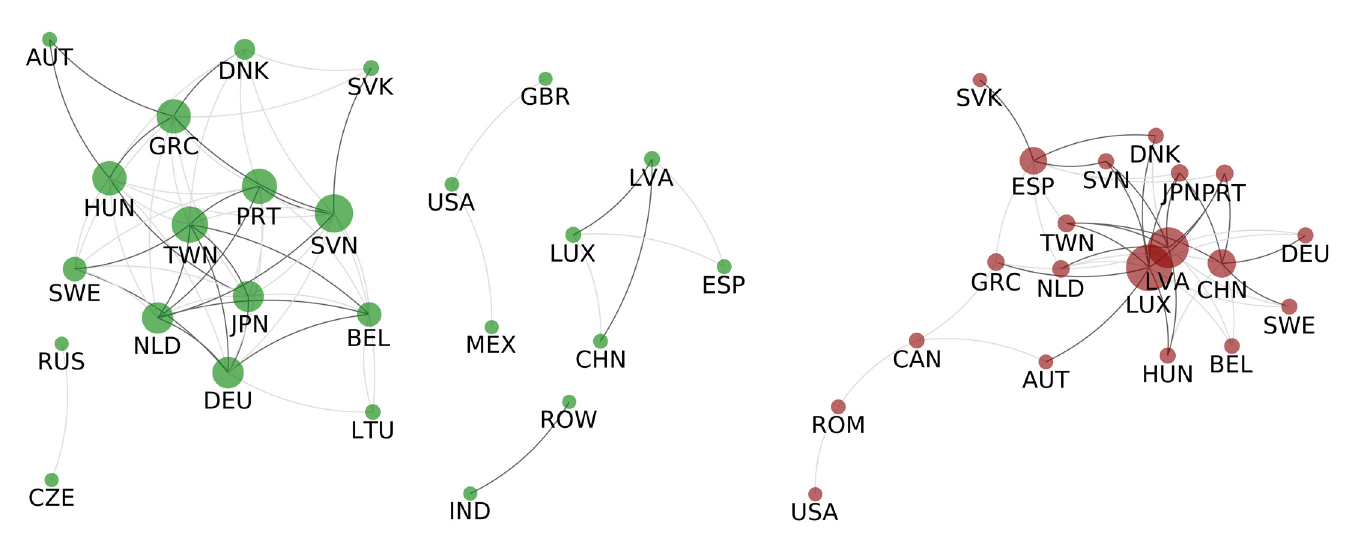
Fig 5. Correlations of Countries’ PageRank. Left: Correlated countries- Two countries are connectedwith a dark grey link if the Pearson coefficient betweentheir PageRank time series is above T þ countriesare connectedin dark grey if their PageRank time series have a Pearson coefficient below T (cid:0) link is light grey. In both the size of of the nodes is proportional to the strength of the node (regardinglight edges).